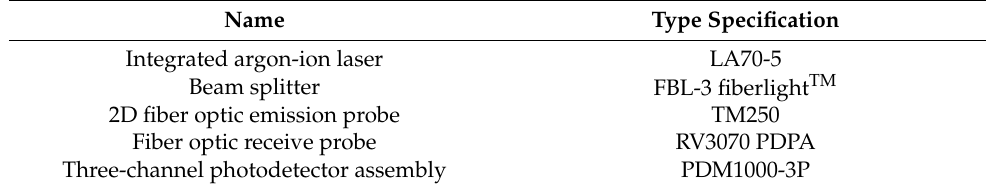
Table 1. Basic device